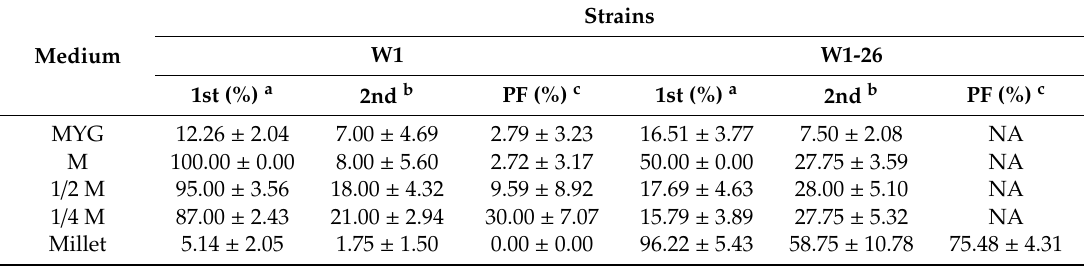
a Mean germination frequency per assay ± SE (standard error) in the first selection. b Mean number of hygromycin-B-resistant colonies per plate ± SE in the second selection. c Mean positive frequency (PF) of polymerase chain reaction (PCR) analysis per assay ± SE after the third selection. NA indicates no hygromycin-B-resistant colonies detected after three rounds of selection; M: Sawdust medium.